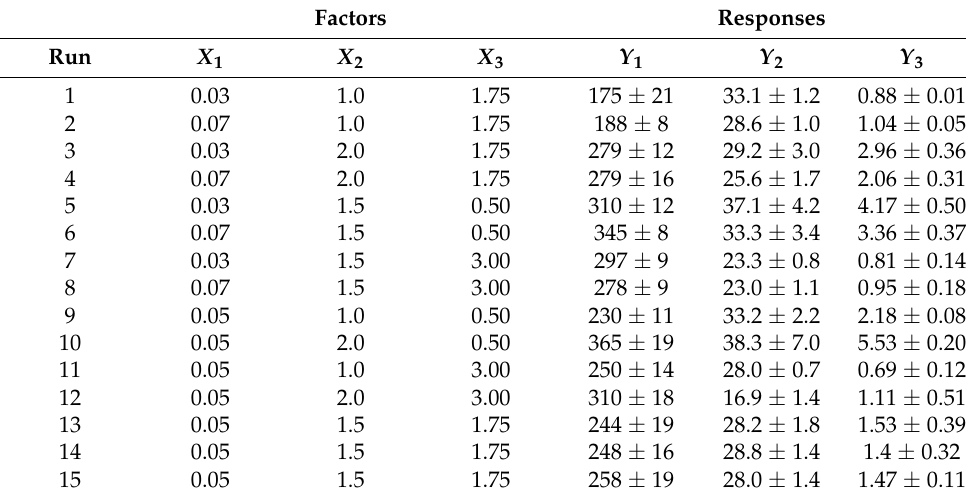
Table 2. Box-Behnken experimental design matrix and response values for the optimization of TO-FA-CS-Alg-NC formulation. Factors Responses Run X